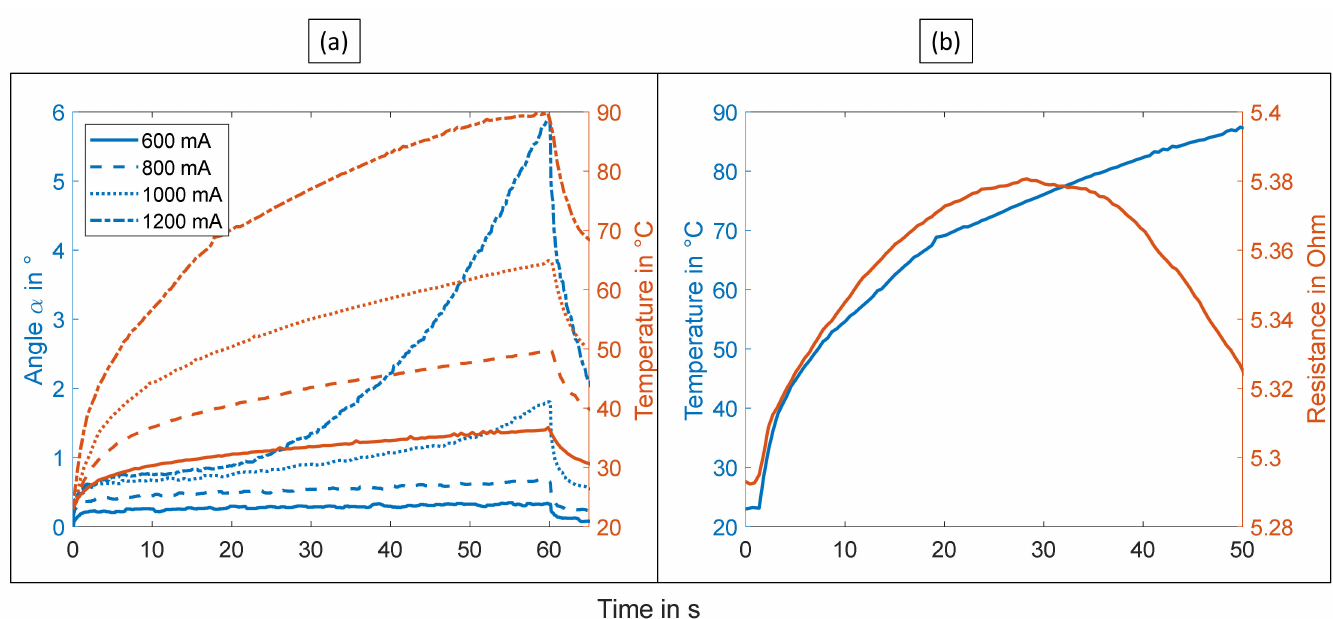
Figure 5. ( a ) Deformation and temperature measured by the integrated temperature sensor at different currents; and ( b ) resistance of the SMA wire during heating versus temperature measured with the integrated temperature